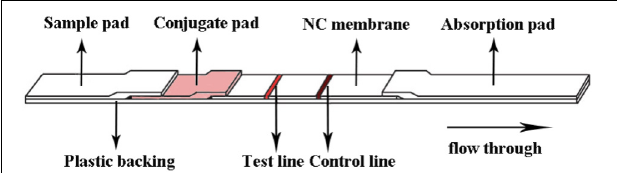
FIGURE 1 | Schematic diagram of the immunochromatographic